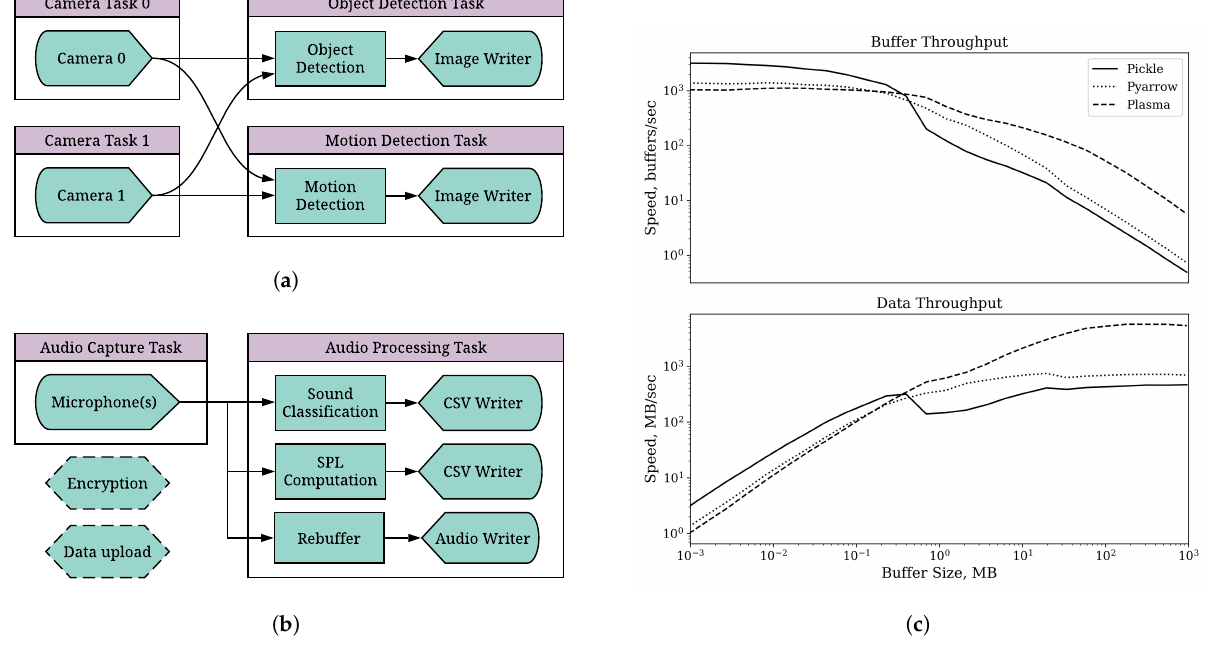
Figure 4. Data processing pipelines used to benchmark REIP SDK (left) and comparison of different serialisation strategies. ( a ) Video processing pipeline for investigation of REIP SDK performance overhead in different configurations (Table 2). ( b ) Audio processing pipeline for comparison of the overall performance of REIP SDK on different platforms (Table 3). ( c ) Data throughput between two blocks as a function of buffer size and serialisation strategy for inter-process communication on Jetson Xavier NX. Pickle serialisation has the lowest overhead for small buffers whilst Plasma method provides the highest data throughput for larger